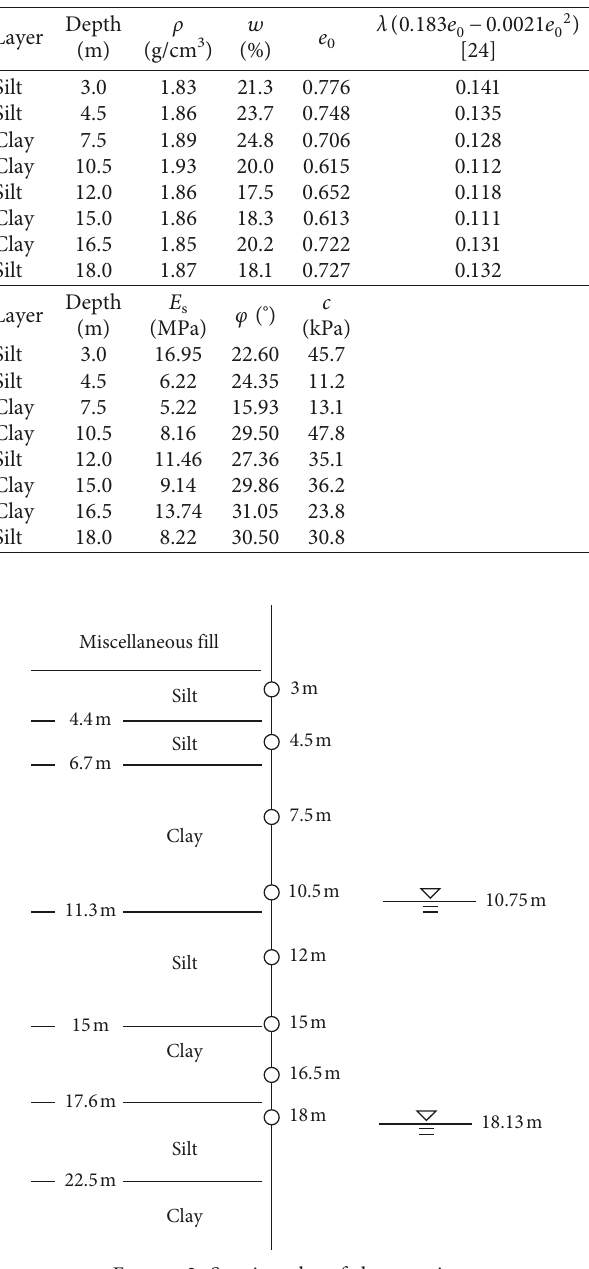
Table 1: Geotechnical parameters of the soil.